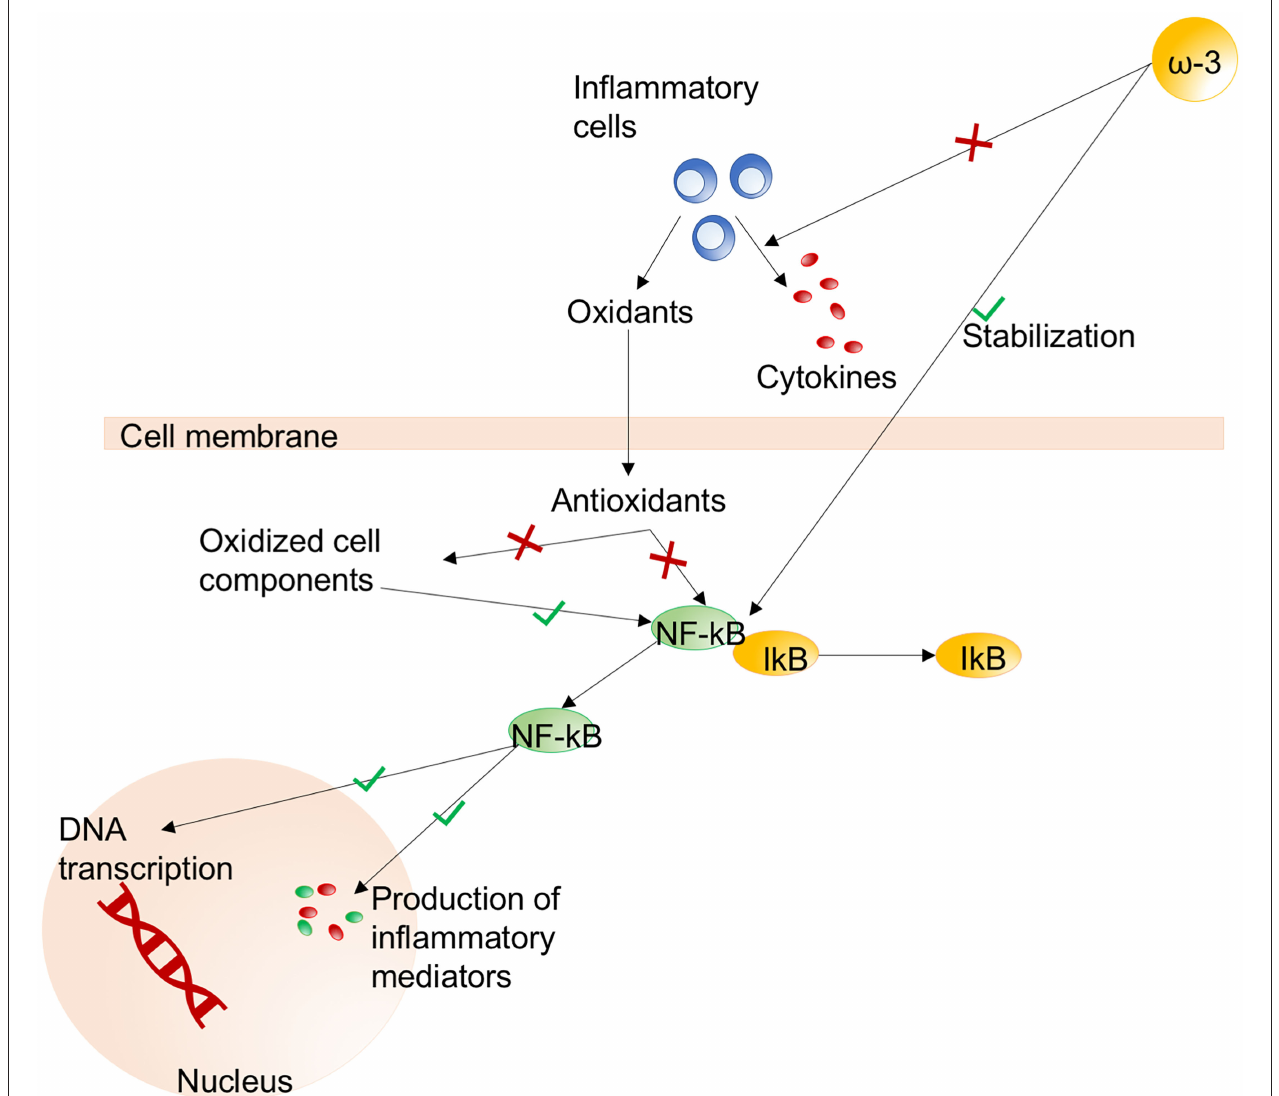
FIGURE 4 | Immunonutrition. The main pathways activated (green) or inhibited (red) during immunonutritional therapy. Effects of omega-3 fatty acids on stabilization of the NF- κ B/I κ B pathway and reduced production of cytokines from inflammatory cells. Effects of NF- κ B on the nucleus include DNA transcription and production of inflammatory mediators. NF- κ B, nuclear factor kappa-B; ω -3, omega-3; DNA, deoxyribonucleic acid. Modified from Grimble (100). immunomodulation of lymphocyte, neutrophil, and